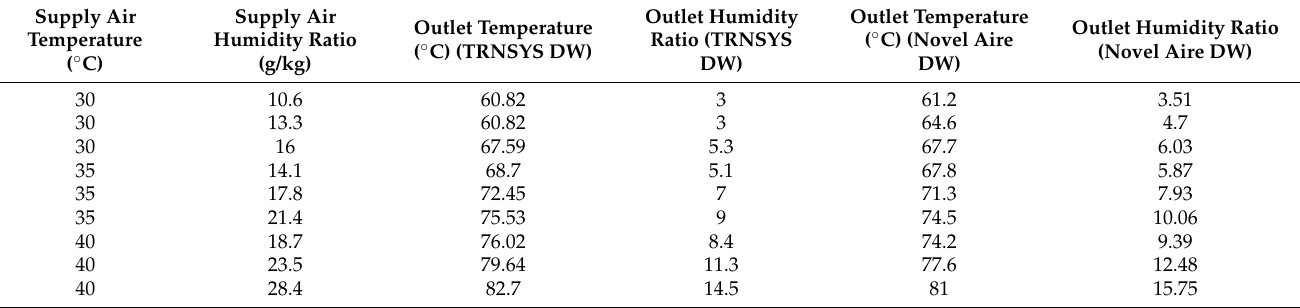
Table 2. Comparison of the process air outlet temperature exiting the DDW of the TRNSYS DDW component and Novel Aire DDW simulation software under the same climatic